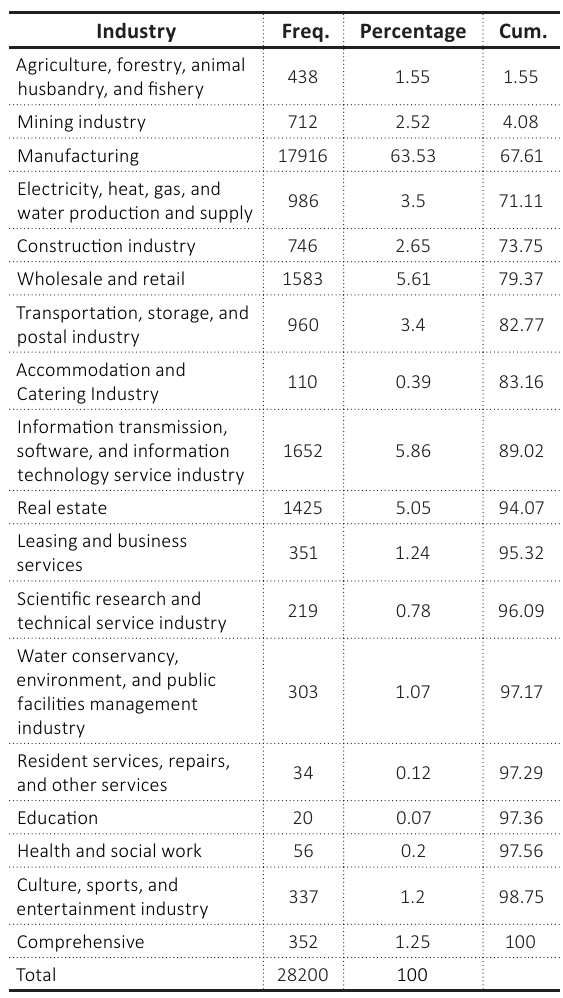
Table 2. Industry distribution of the